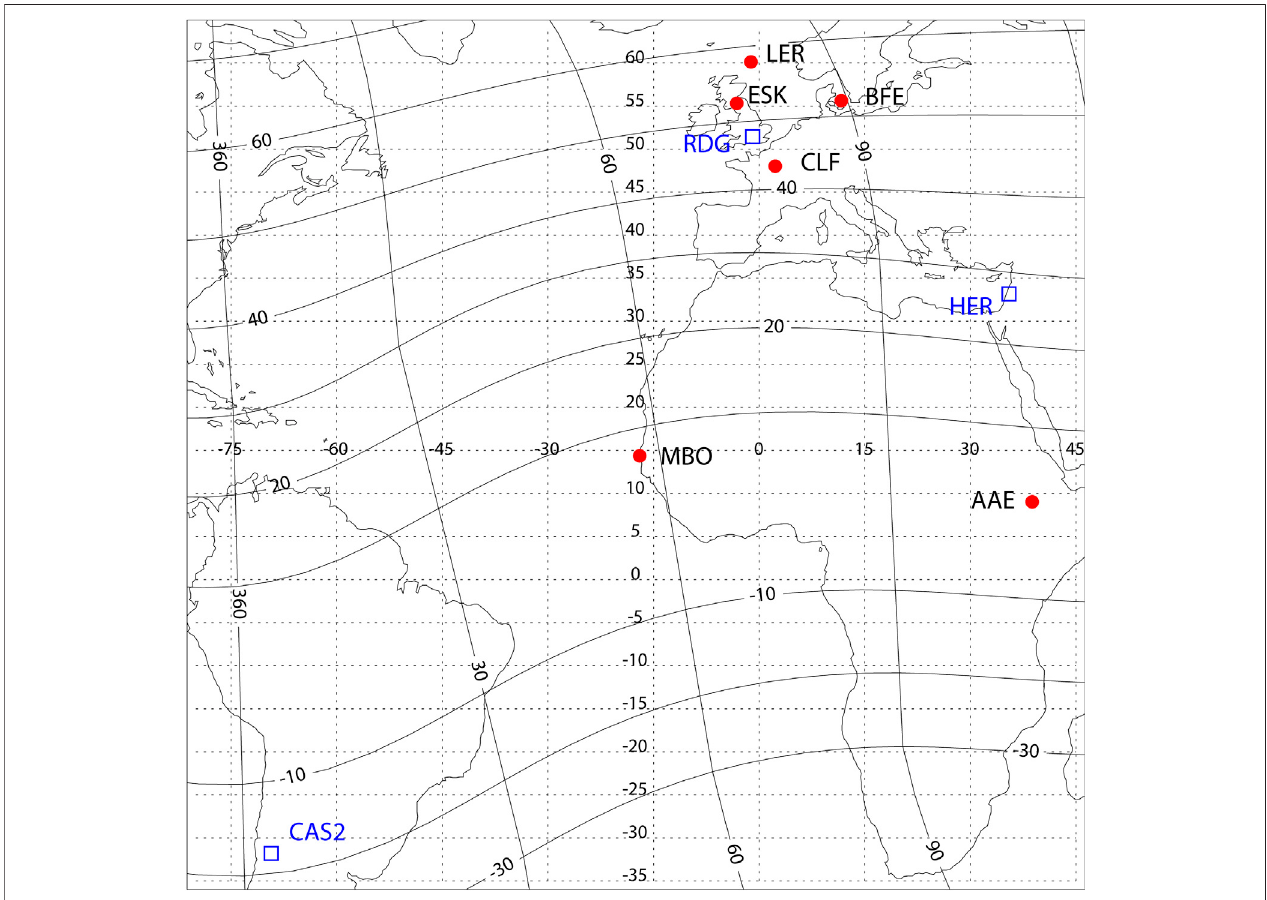
FIGURE1| Themapwithlocationofselectedatmosphericelectricitystations(blueemptysquares)andmagnetometers(reddots).Solidlinesdenotegeomagnetic coordinates, and dotted lines correspond to geographic coordinates.